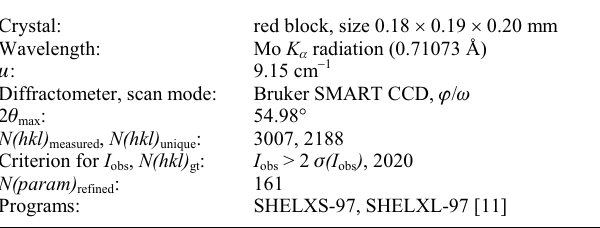
Table 1. Data collection and handling.